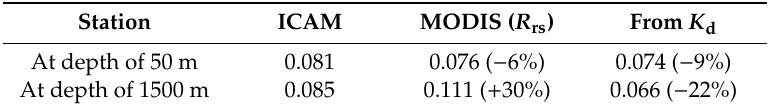
Table 1. The values of a g (443) measured by integrated cavity absorption meter (ICAM), and calculated according to Moderate-Resolution Imaging Spectroradiometer (MODIS) ( R rs ) and light measurements ( K d ) in 2018. The relative error (%) is indicated in